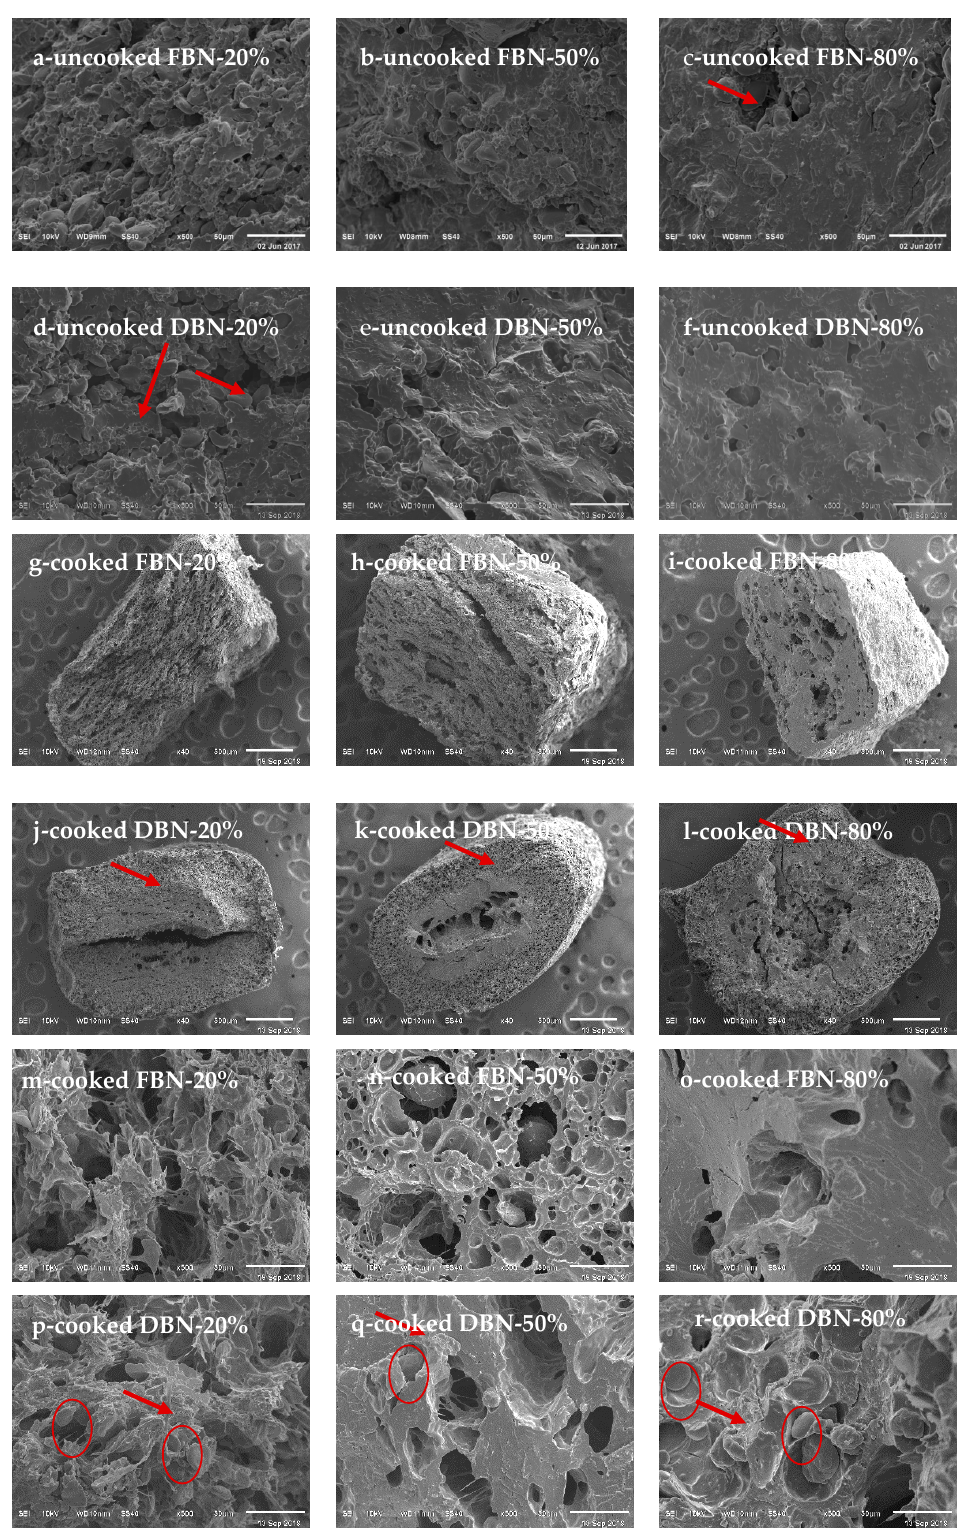
versus Figure 3q), but the DBN-80% swelled to a higher degree, showing a looser struc- ture, implying there was a soft texture of cooked noodles.